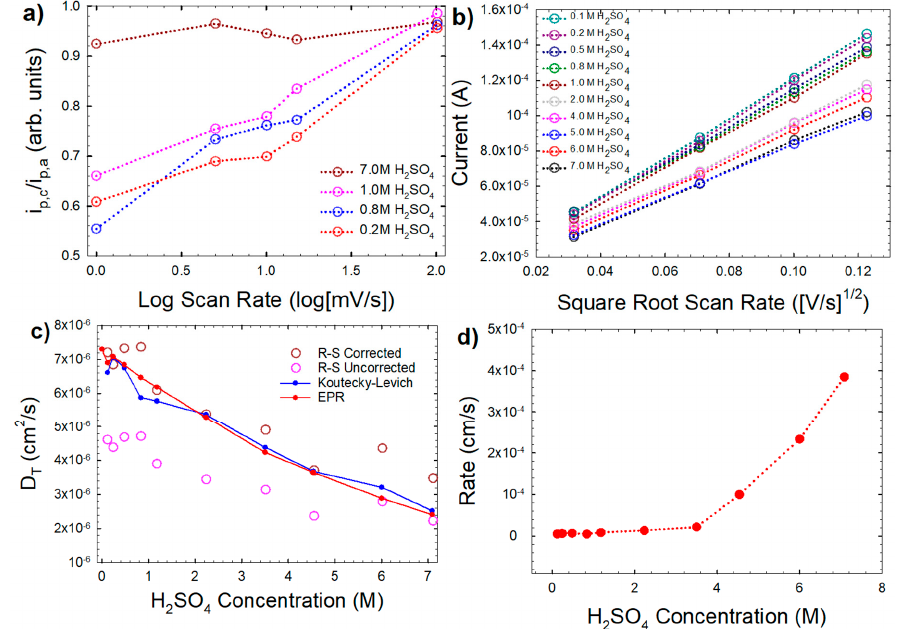
Figure 6. ( a ) Peak current ratios for the CVs of 0.01 M VO 2+ in the indicated H 2 SO 4 solutions as a function of scan rate (shown here as log of scan rate for clarity); ( b ) Randles–Sevcik (R–S) analysis of the CVs (four slowest scan rates) using Equation (8); ( c ) translational diffusion coefficient ( D T ) calculated from R–S analysis for corrected (red circles) and uncorrected (dark red hollow circles) peak currents in comparison to values obtained via K–L and EPR analyses (the latter from Figure 3). The peak current correction applied was +20% added to the anodic peak. ( d ) Heterogeneous rate constant ( k 0 ) at varying H 2 SO 4 concentrations, as calculated using Equation